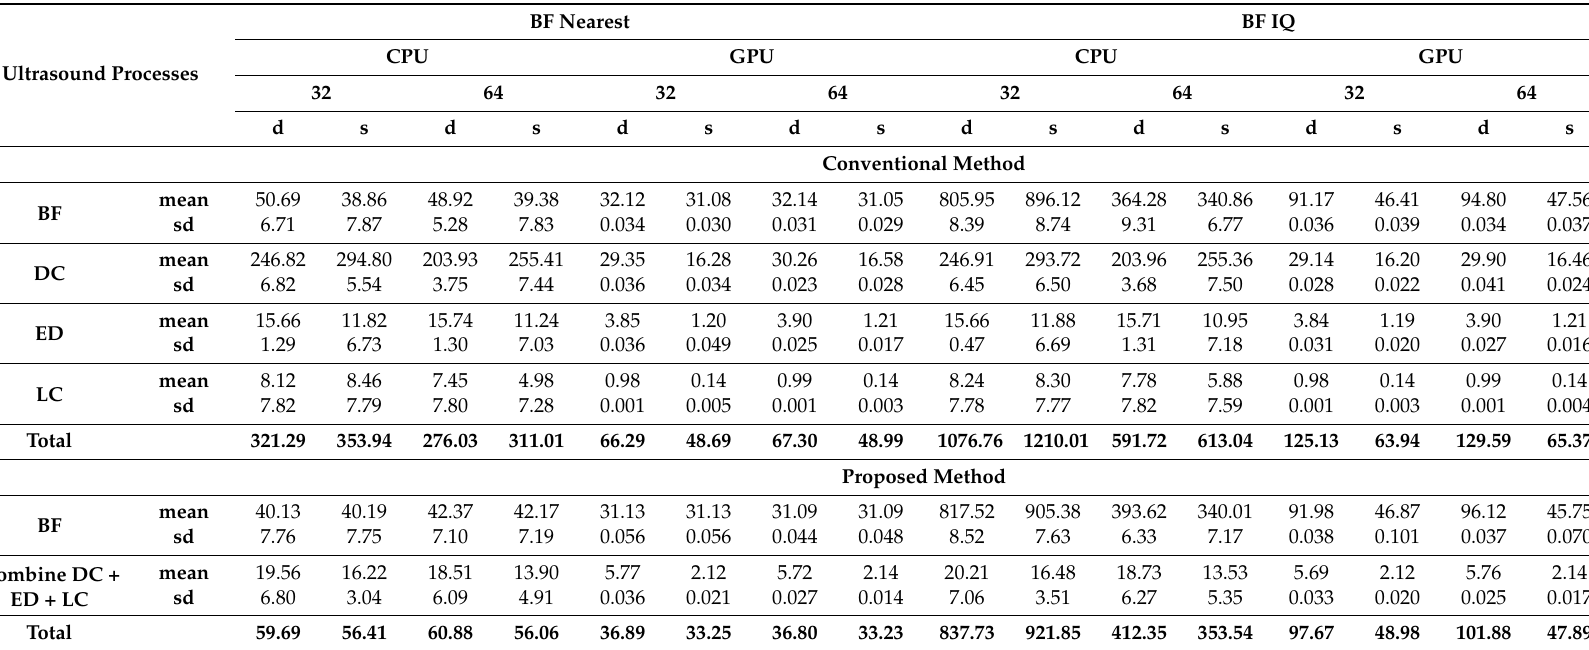
Table 1. The mean and the standard deviation of the computational time (ms) for ultrasound image reconstruction using different schemes calculated over 500